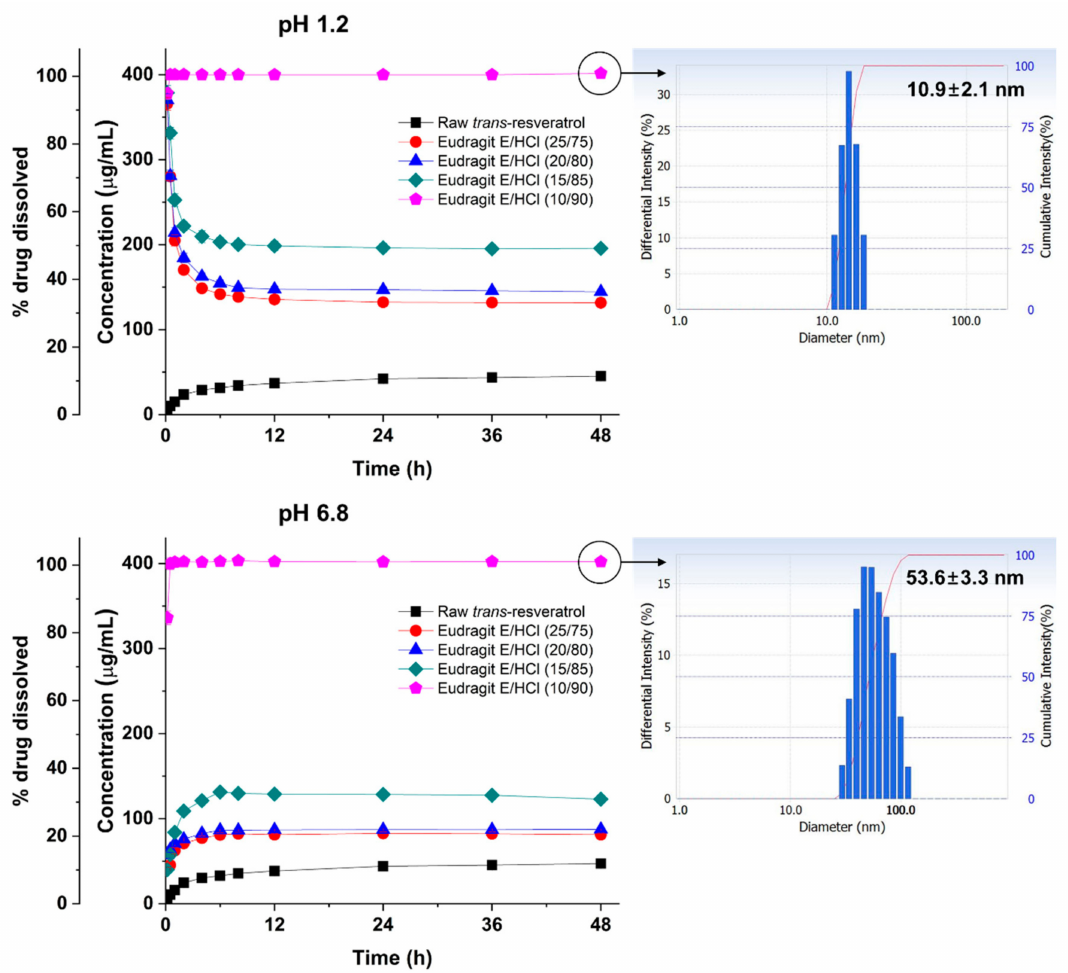
Figure 4. Effect of Eudragit E/HCl ratio on the dissolution of trans -resveratrol from solid dispersions in pH 1.2 and 6.8 dissolution